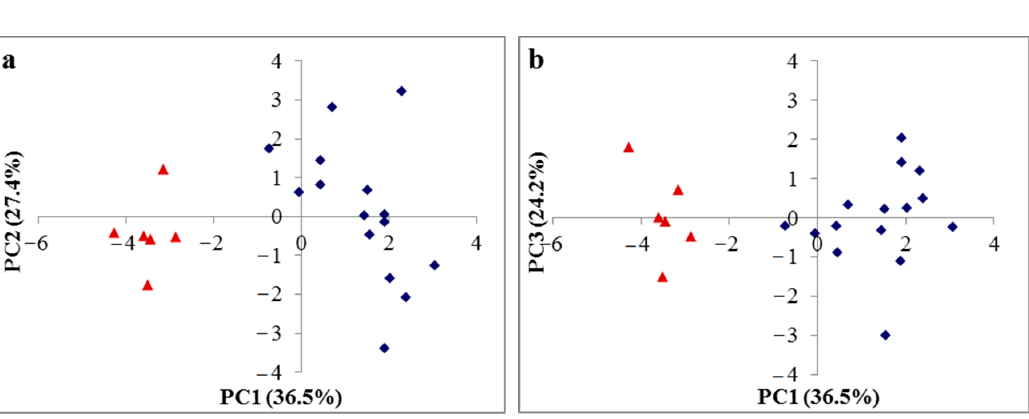
Figure 2. Principal component scores scatter plot for 21 beer samples: ( a ) Score scatter plots of PC1 vs. PC2 and ( b ) score scatter plots of PC1 vs. PC3. For illustration purposes, blue rhomb represents wheat beers and red triangle represents barley malt beers.